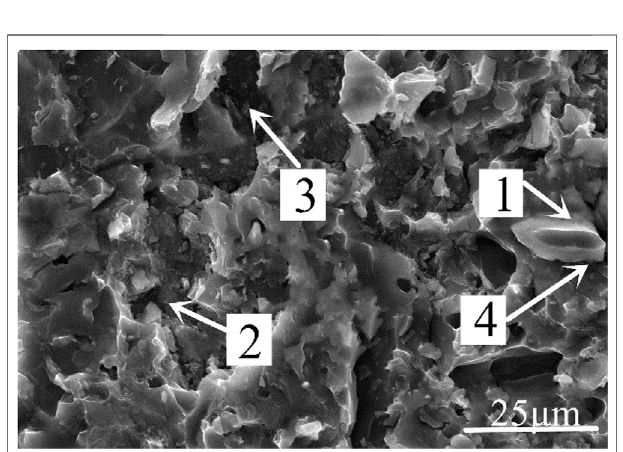
FIGURE 10 | Micromorphology of α zone in Figure 9 .